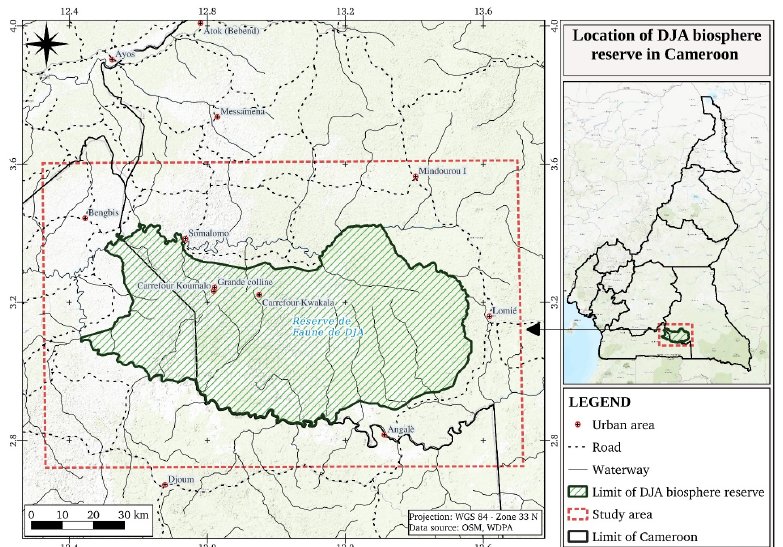
Figure 2. Location map of the Dja Biosphere Reserve.